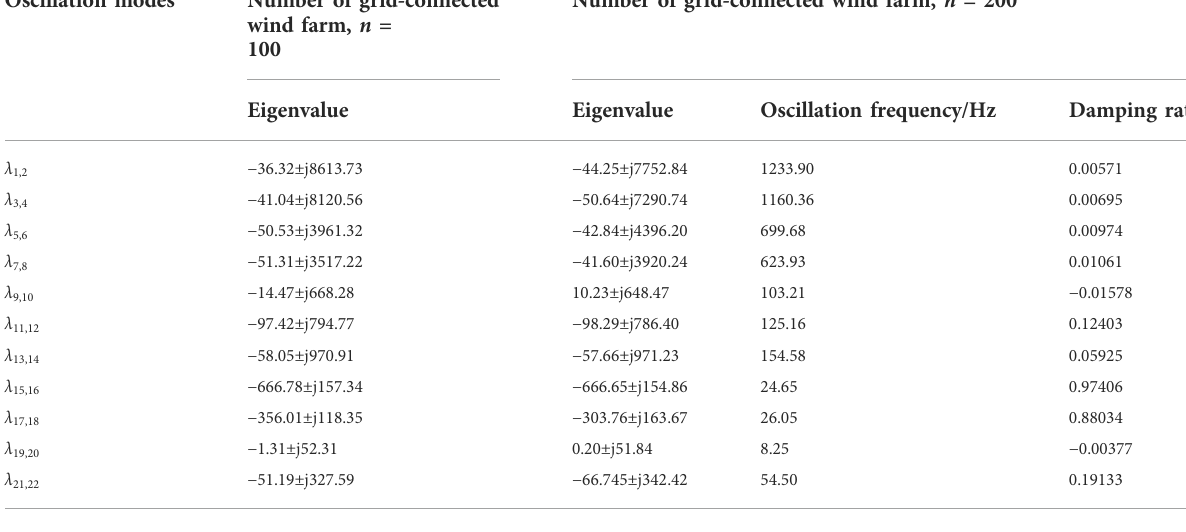
TABLE 5 Main oscillation modes of the system of the wind farm sending out via